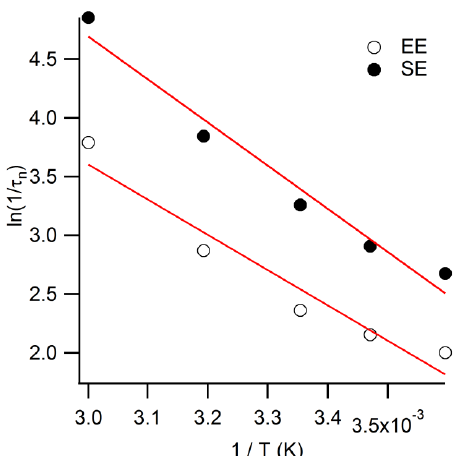
Figure A1. Arrhenius plot comparing the inverse of electron lifetime values calculated from OCVD decay transients [24]. SE- and EE-illumination direction compared.